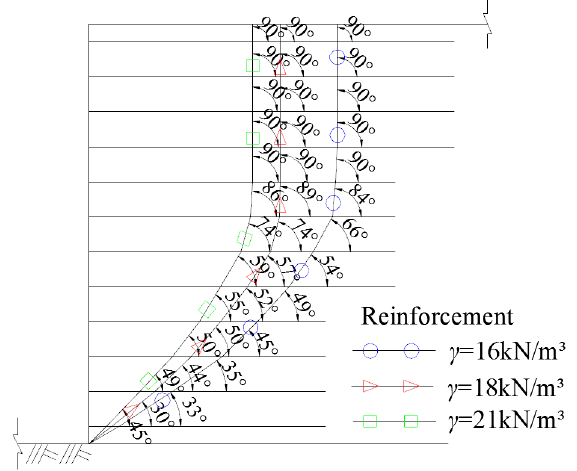
Figure 10. Inclination angle of slip surface and horizontal direction for various unit weights.